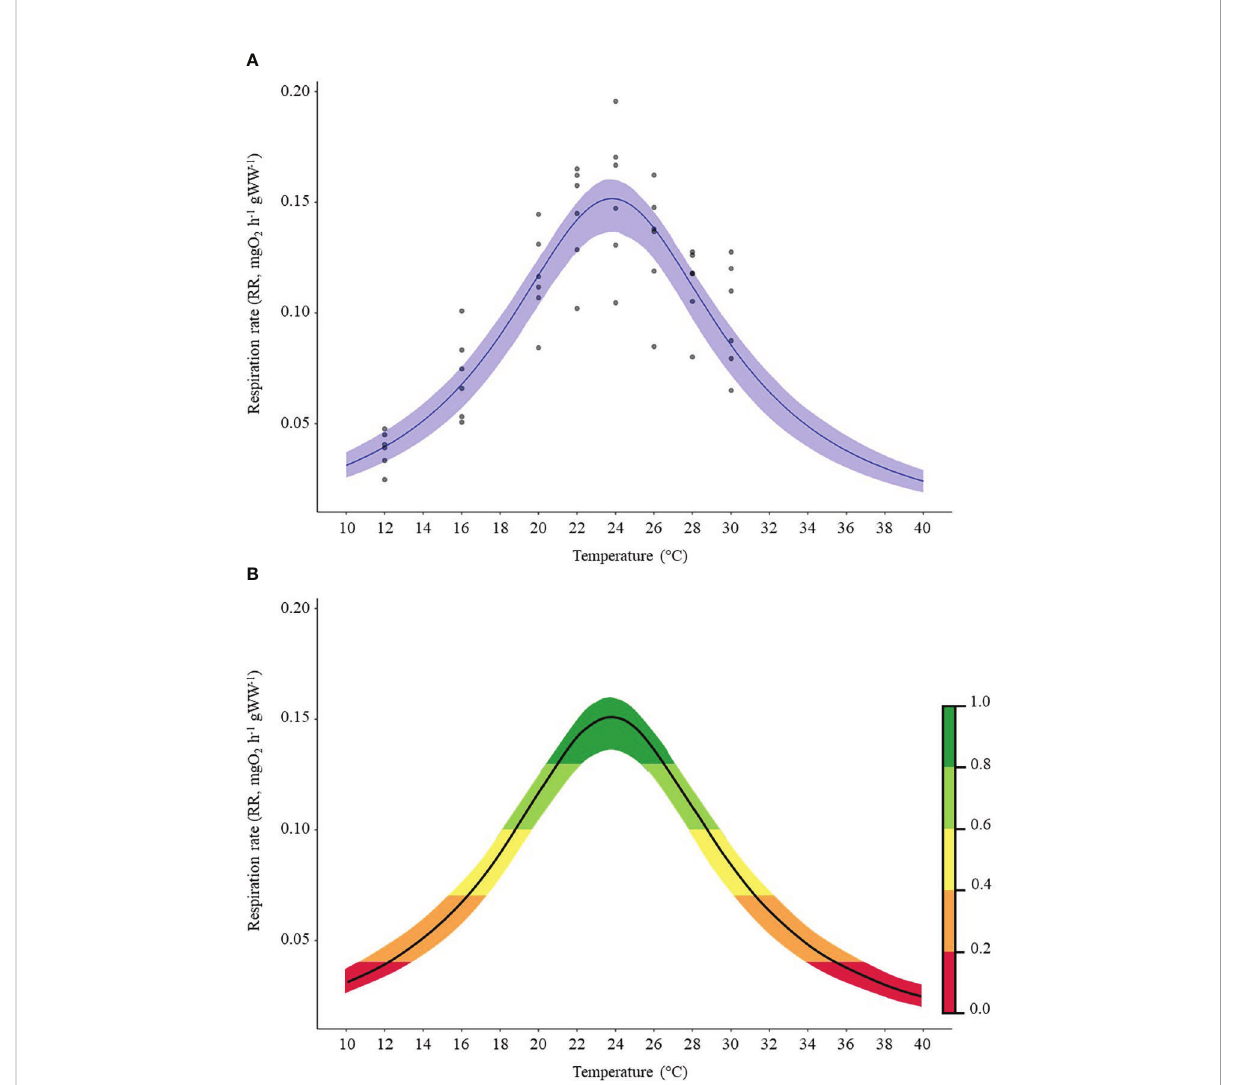
FIGURE 3 (A) Thermal Performance Curve (TPC) according the Flinn model based on the respiration rates (mgO 2 h – 1 gWW – 1 ). The blue band represent the 95% con fi dence interval; (B) Thermal habitat suitability (THS) scale within the TPC of Callinectes sapidus ranging from low (0) to high (1) species thermal suitability probability. Different colors (representing the species THS) would correspond to: optimum temperature range (green colored), lower and upper pejus ranges (light green and yellow colored), pessimum (orange colored), and lethal ranges (red colored) (Sokolova et al.,